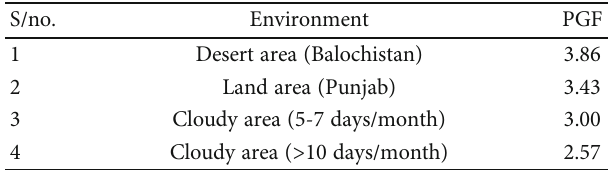
Figure 20: Solar pro fi le. Table 5: Panel generation factor (PGF).